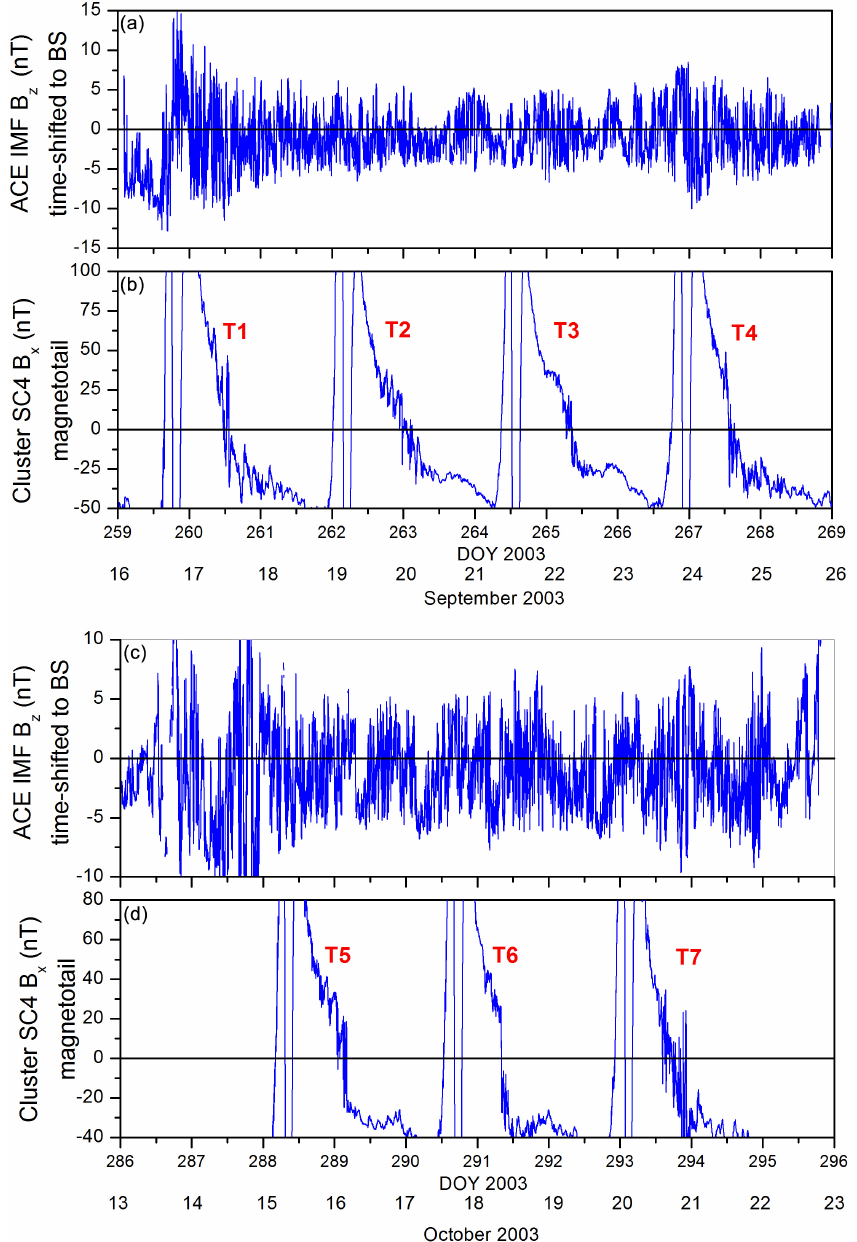
Figure 2. Panel (a) ACE 1min IMF B z component data propagated to the Earth’s bow shock. (b) Cluster C4 B x component data. Time period is DOY 259 to 269 (16 to 26 September 2003). (c) ACE 1min IMF B z component data propagated to the Earth’s bow shock. (d) Cluster C4 B x component data. Time period is DOY 288 to 296 (15 to 22 October